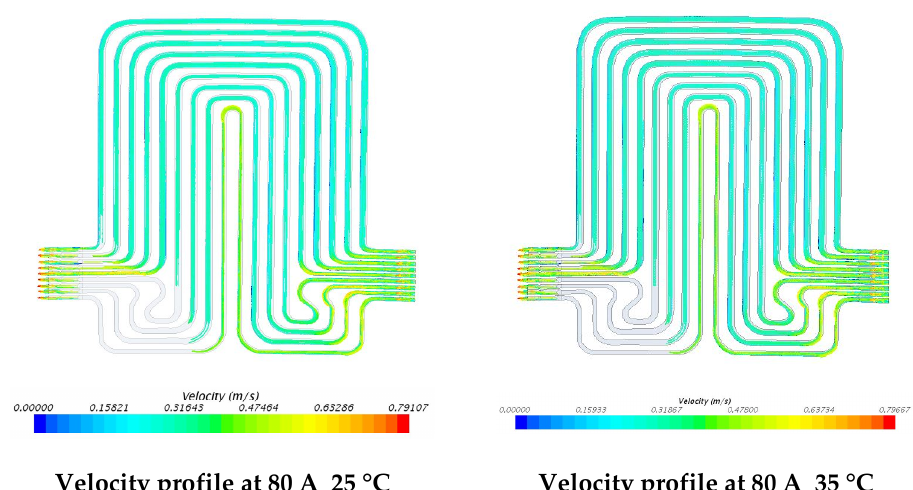
Figure 16. Velocity profile at 80 A with 5 °C, 15 °C, 25 °C, and 35 °C.